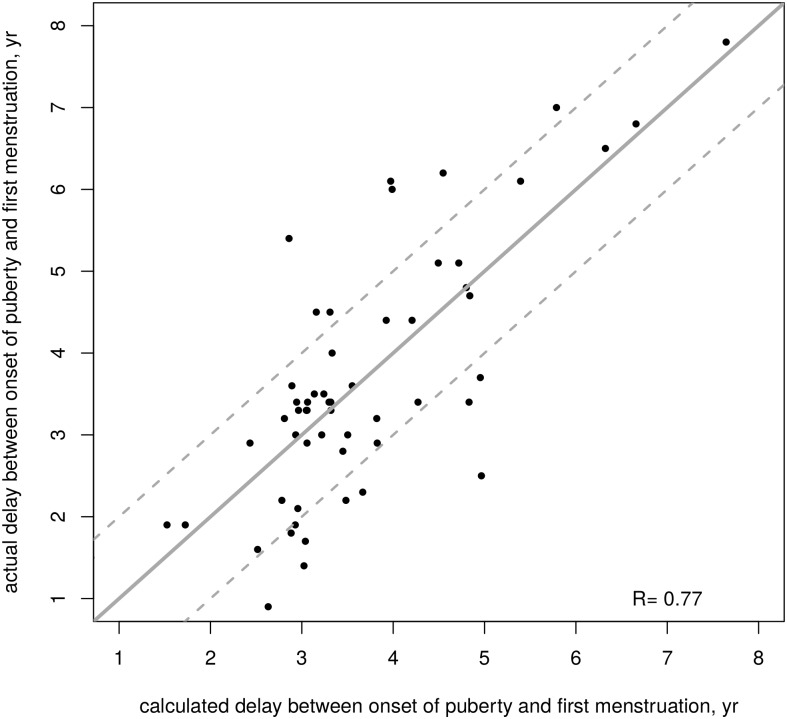
Interval time (years) between the onset of puberty and first menstruation in 56 girls with untreated idiopathic CPP using the formula from http://www.kamick.org/lemaire/med/girls-cpp15.html.Plain line represents the reference perfect prediction (calculated = actual), and dotted lines represent ± year from that value.